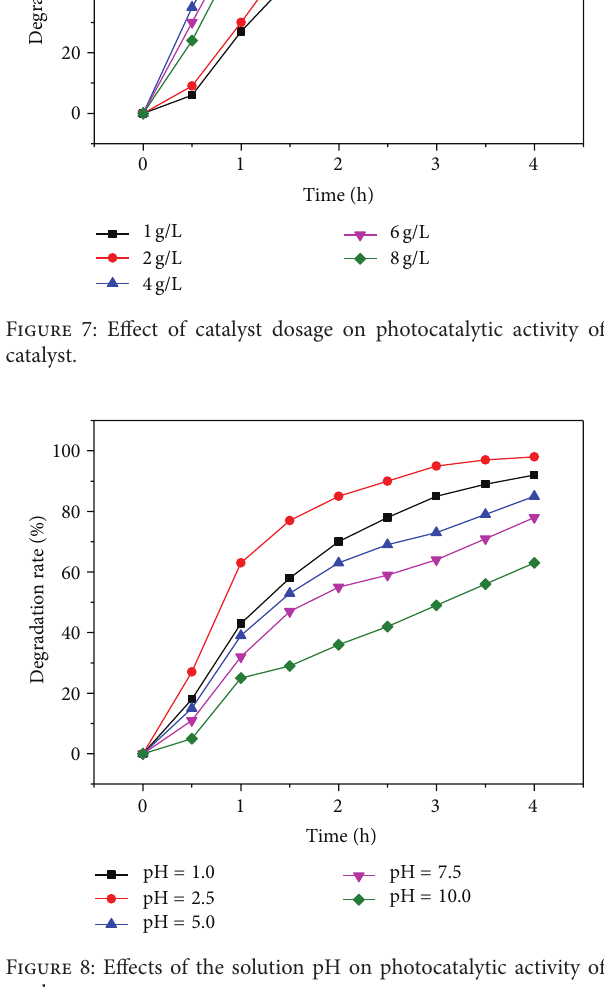
Figure 8: Effects of the solution pH on photocatalytic activity of